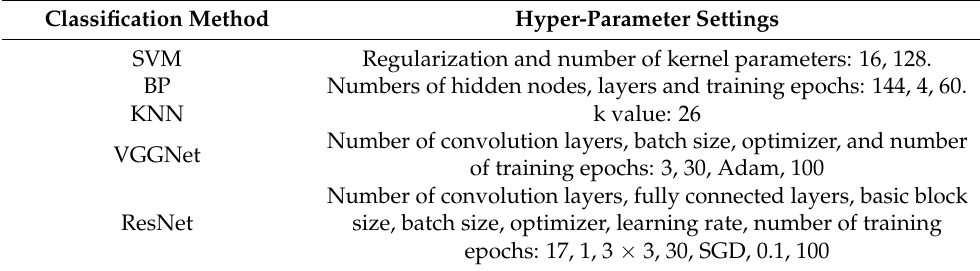
Table 3. Parameter settings of the SVM, BP, KNN, VGGNet, and ResNet.